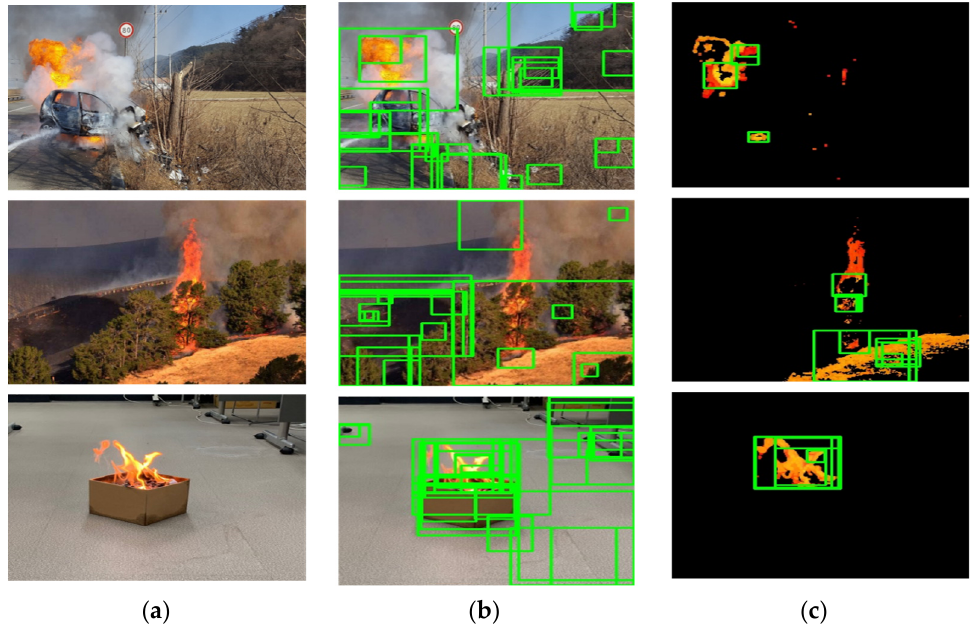
Figure 4. Perform selective search of flame images. ( a ) Original images; ( b ) Selective search for the original images; ( c ) Selective search for the color conversion images.